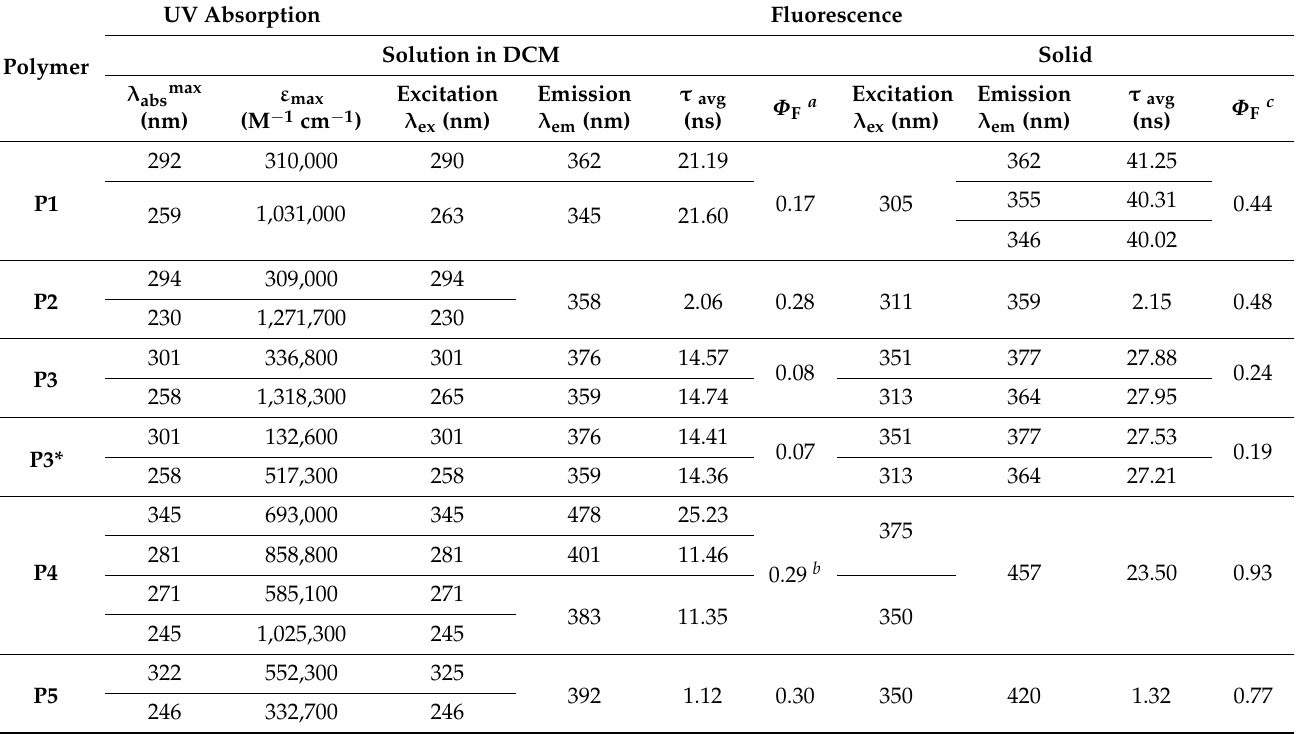
Table 3. Optical properties of polymers P1 – P5